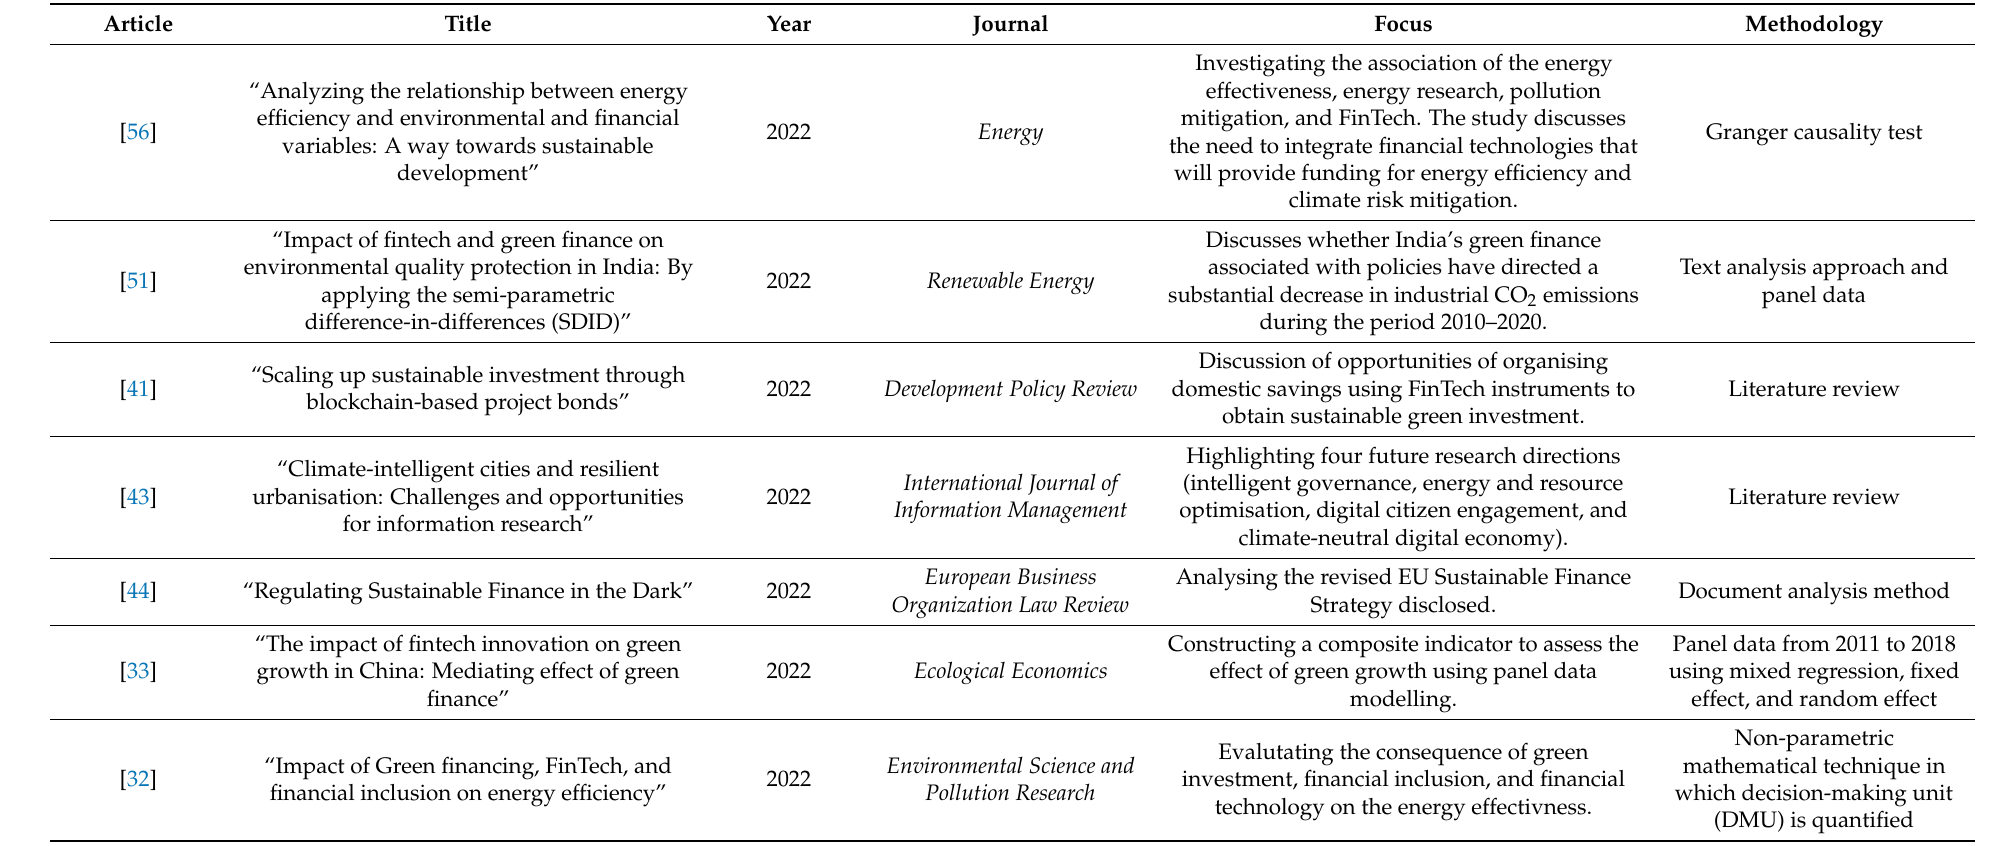
Table A1. Results of the systematic-cum-bibliometric